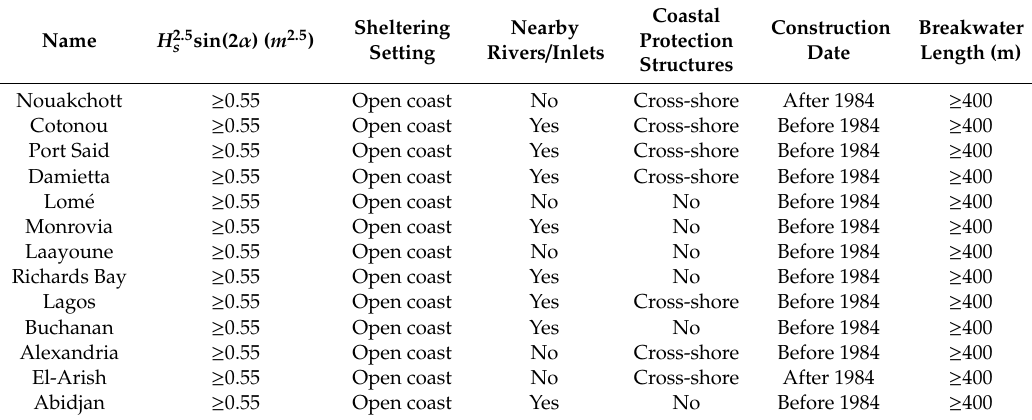
Table 5. Characteristics of hotspot ports in terms of coastline evolution.